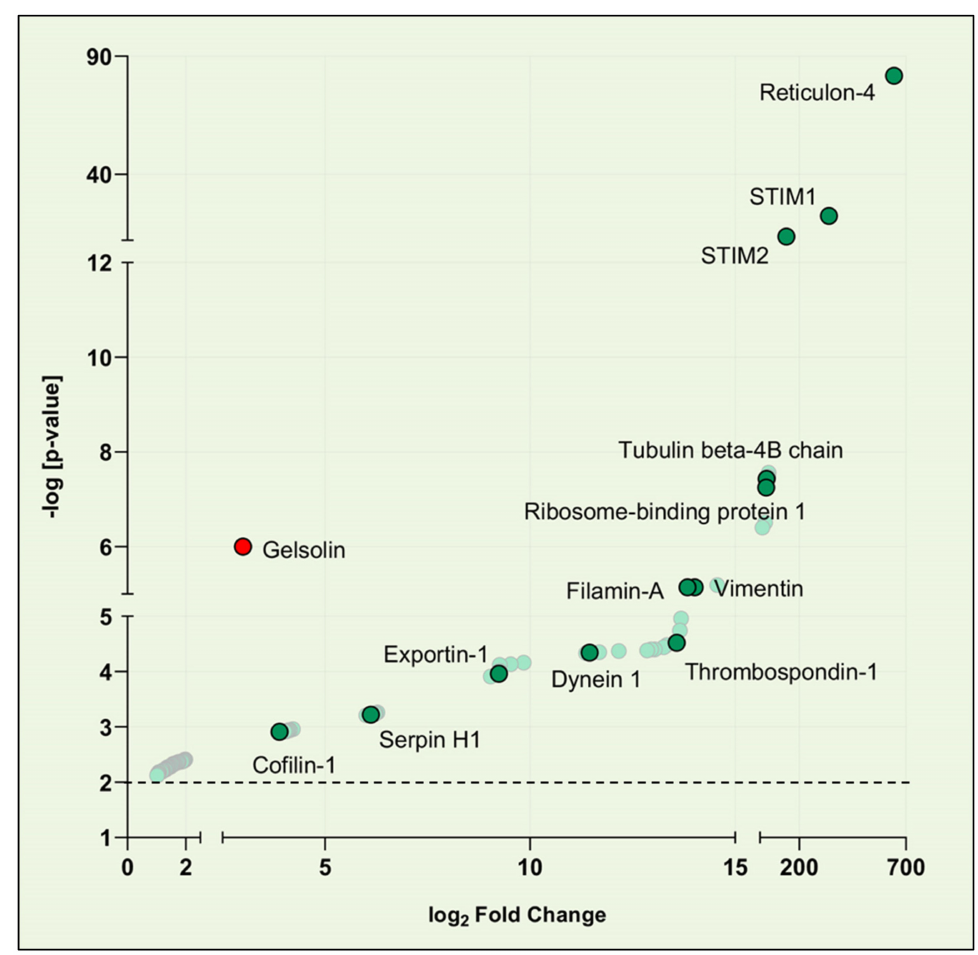
Figure 2. A volcano plot depicting quantified STIM1 proteome identified by MS. For clarity, only the most aboundant proteins ( − log[ p -value] > 2.0) are shown, known STIM1 interactors are labeled. The x -axis shows the average fold change (log2) in protein abundance compared to control, and the y -axis shows the average adjusted − log[ p